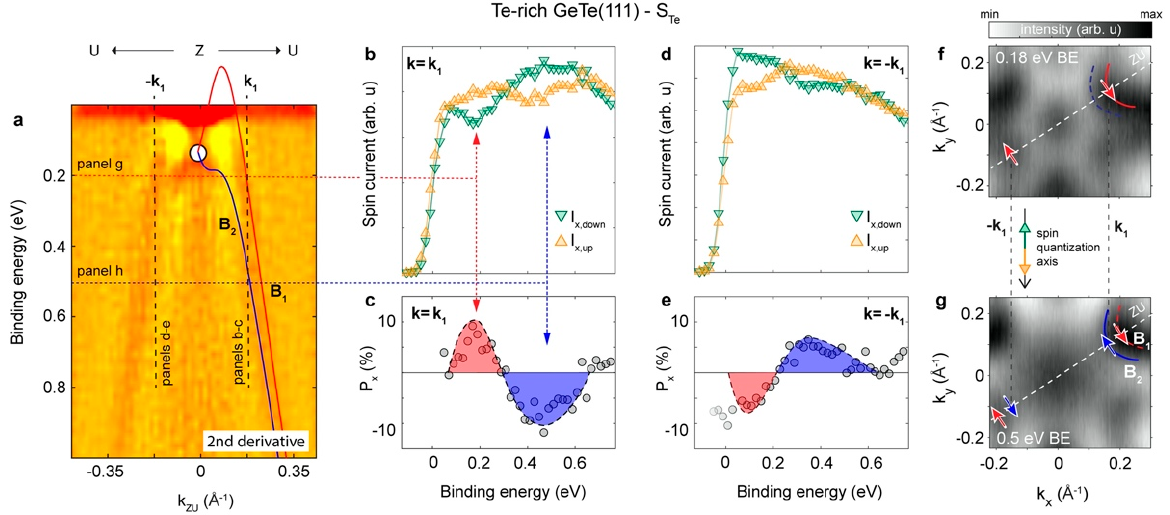
Figure 3. Spin-resolved ARPES for the Te-rich sample (P outwards). ( a ) Calculated bulk bands (solid line) along ZU (k y ) superposed to the 2nd derivative of the measured band dispersion. ( b , c ) Spin-polarized spectra and spin asymmetry at fixed wave vector k 1 indicated in panel a, with the two peaks related to bulk Rashba states at k 1 from B 1 and B 2 bands (panel a). ( d , e ) Spin-polarized spectra and spin asymmetry at opposite wave vector − k 1 . ( f , g ) Constant energy maps at 0.18 and 0.5 eV BE, corresponding to the energy of bulk bands B 1 and B 2 at k 1 . Blue and red arrows indicate the sense of circulation of spins: clockwise in the outer band and counterclockwise in the inner one. Reprinted with permission from Ref. [88]. Copyright © 2022 American Chemical Society.